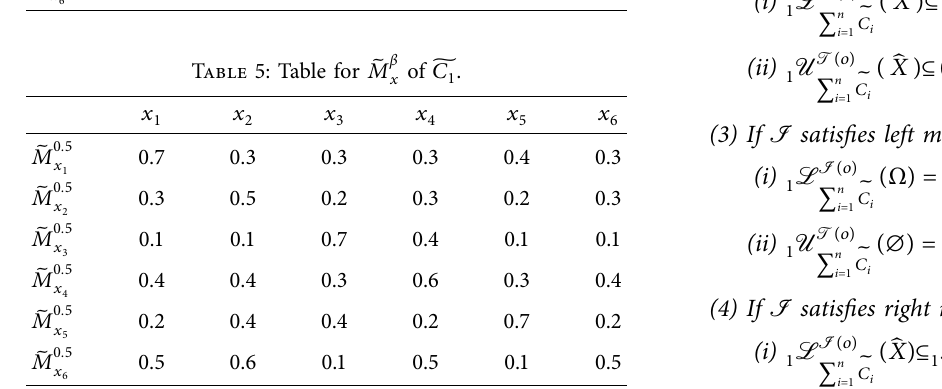
Table 5: Table for 􏽥 M β